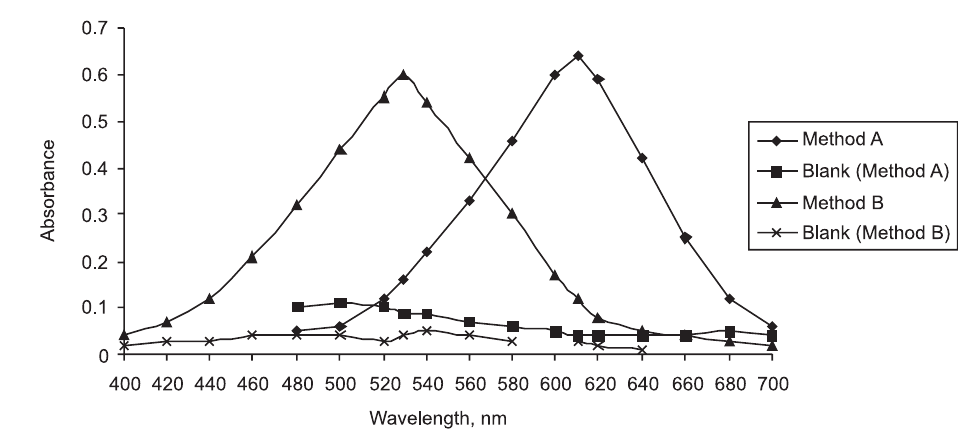
FIGURE 2 - Absorption spectra (4.0 µg/mL OFX in method A and 2.4 µg/mL in method B).